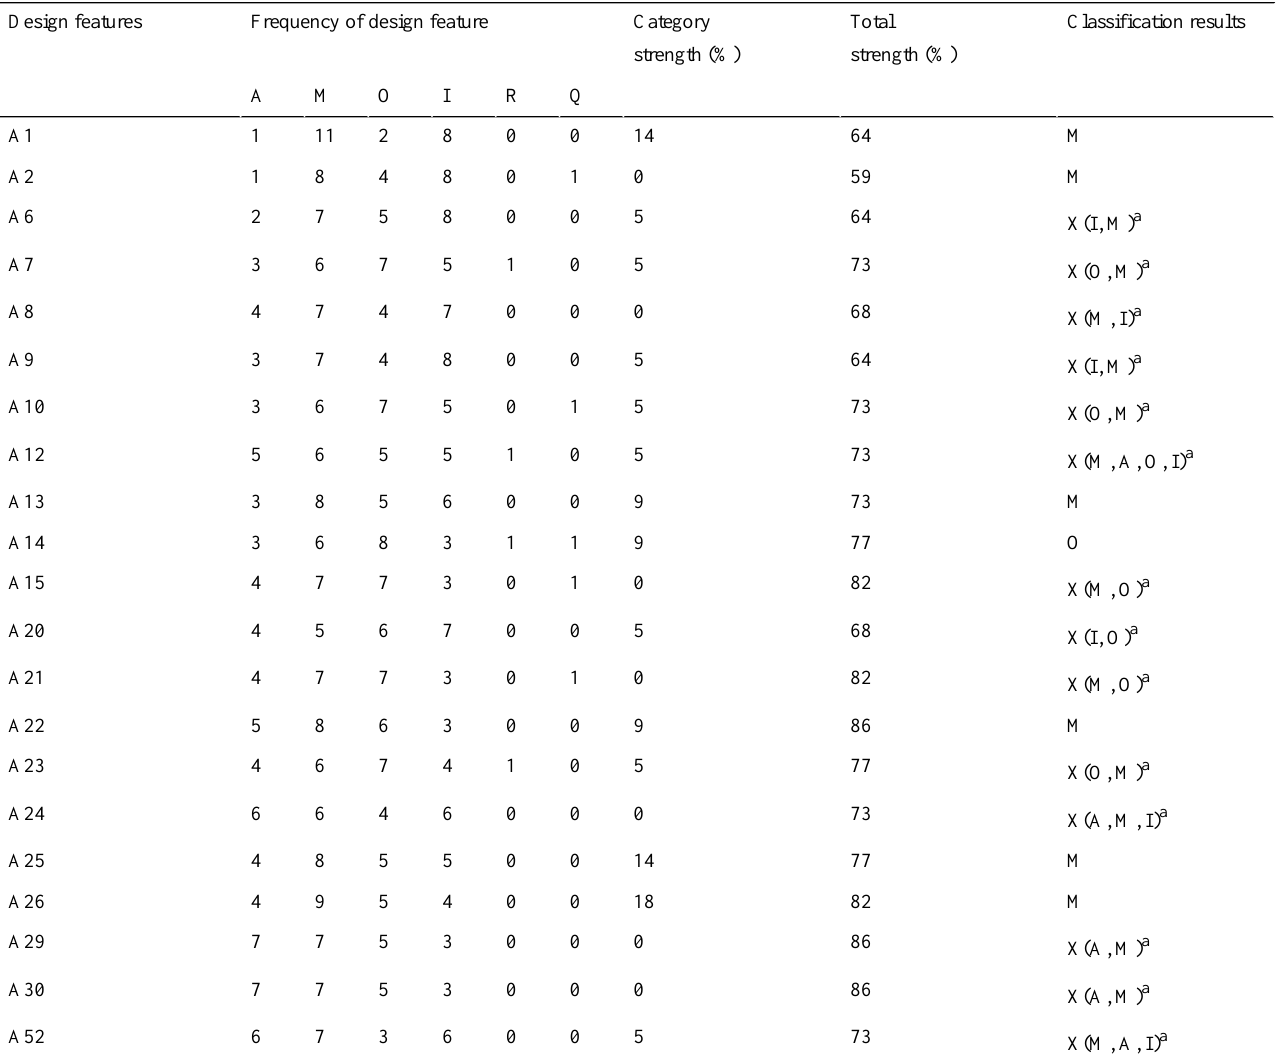
Table 7. Categorizing design features by low physical activity participants